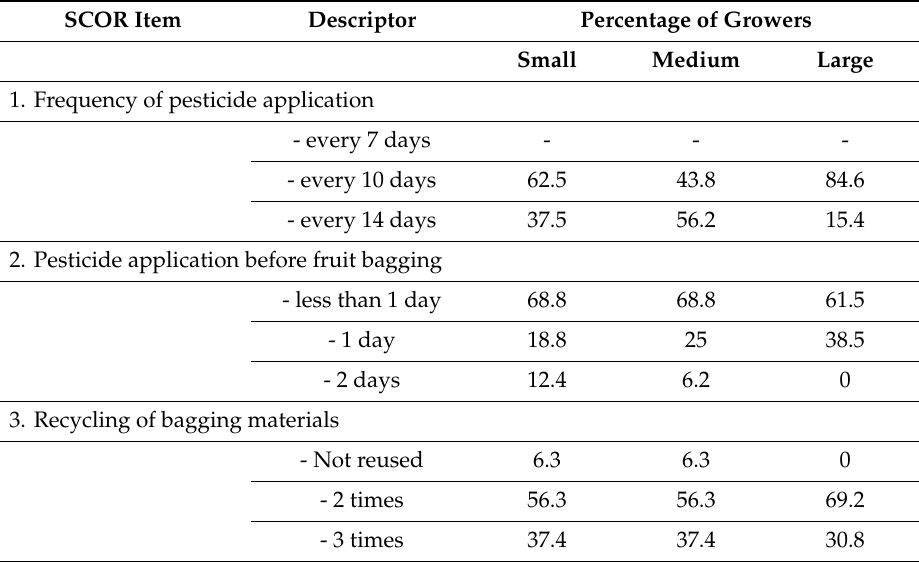
Table 5. Practices in mango production fields with di ff erent farm sizes followed by the supply chain operation reference (SCOR) model.